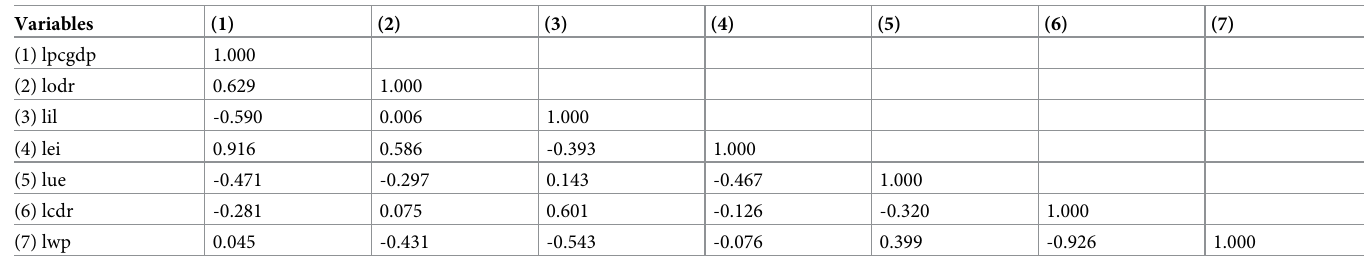
Table 7. Pairwise correlation of central region of China.